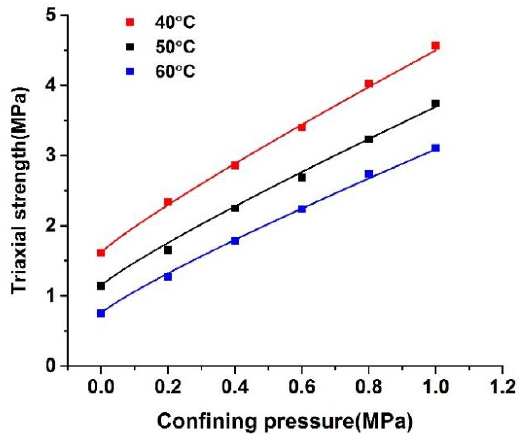
Figure 6. Triaxial results of AC-13 asphalt mixture.